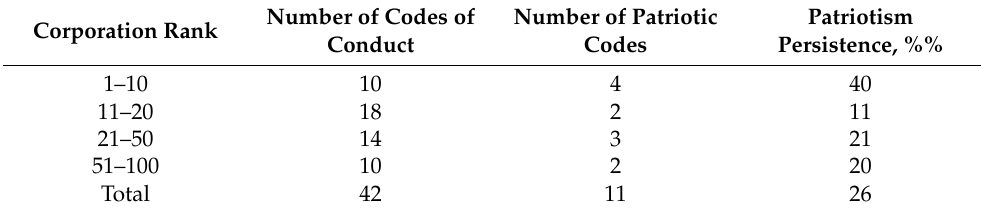
Table 2. Frequency of patriotism consideration in the analyzed codes of